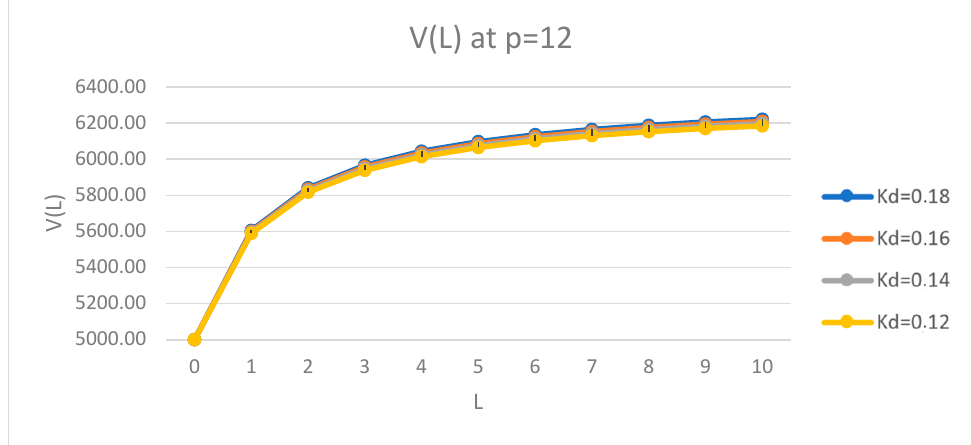
Figure 14. Dependence of the company capitalization, V, on leverage level L at different debt cost k d (12%; 14%; 16%; 18%) and fixed frequency of payments of tax on profit p = 12.